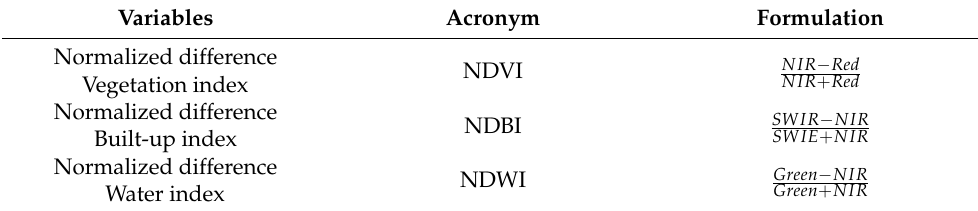
Table 1. Downscaling process applied surface parameters.